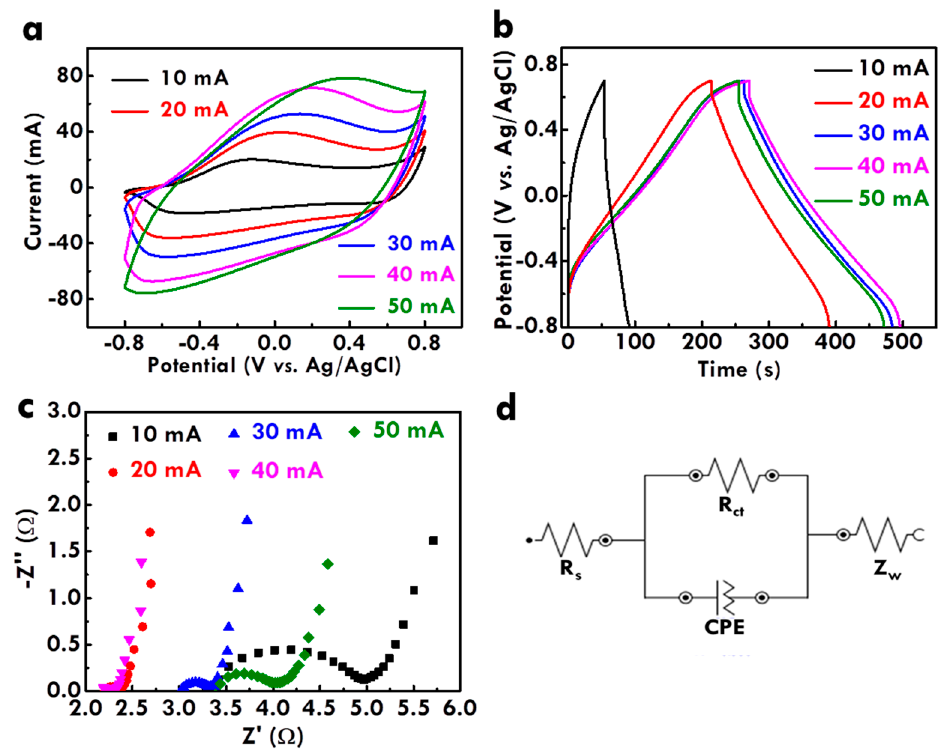
Figure 2. ( a ) The cyclic voltammetry (CV) curves at 20 mV/s, ( b ) the Galvanostatic charge/discharge (GC/D) curves at 1 A/g, and ( c ) the Nyquist plot for carbon fiber on polypyrrole (CF@PPy) prepared using 10 min at different applied currents in the 0.5 M pyrrole and 0.3 M NaClO 4 electrolyte; ( d ) the equivalent circuit for fitting the Nyquist plot in ( c ).